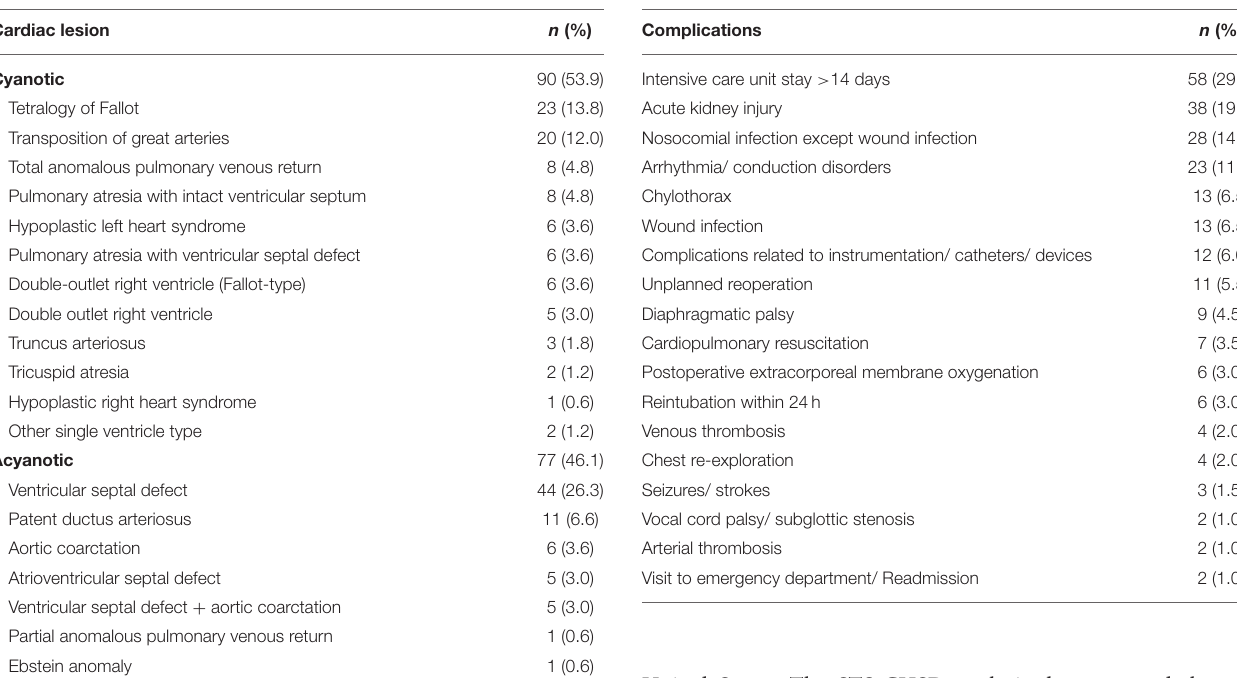
TABLE 3 | Types of congenital heart disease ( N = 167). TABLE 4 | Postoperative complications ( M =